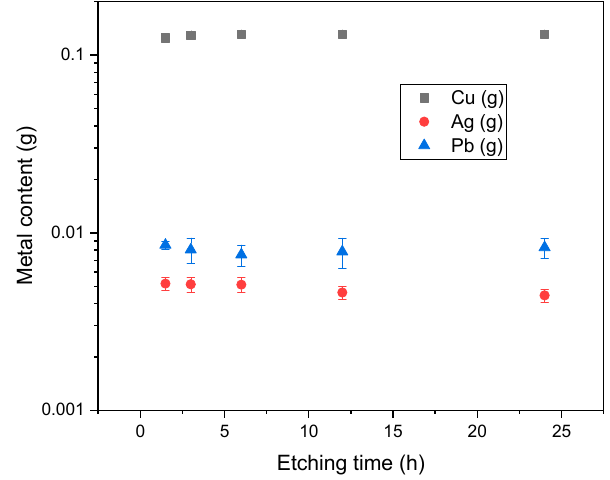
Figure 5. Influence of etching time on dissolved metal content.